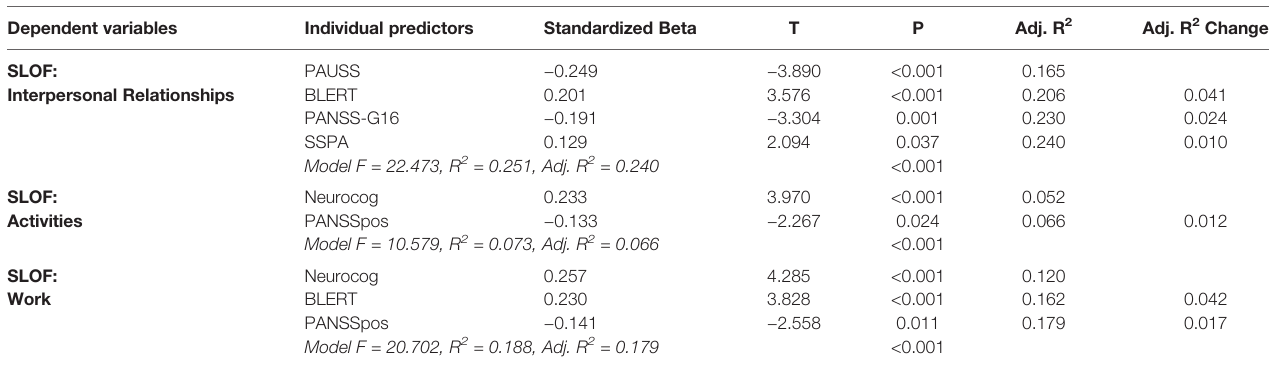
TABLE 7 | Predictors of functional outcome in patients with Low PANSS-G16 (3 or lower) (Stepwise linear multivariate regressions). Dependent variables